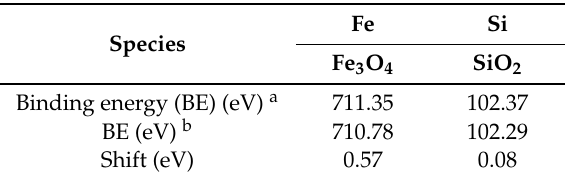
Figure 13. C1 XPS of the flocculated initial concentrate.